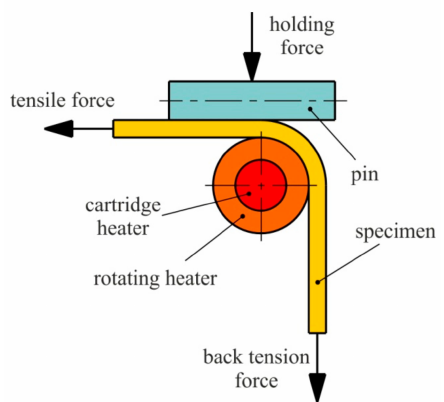
Figure 21. Schematic of the hot bending under the tension